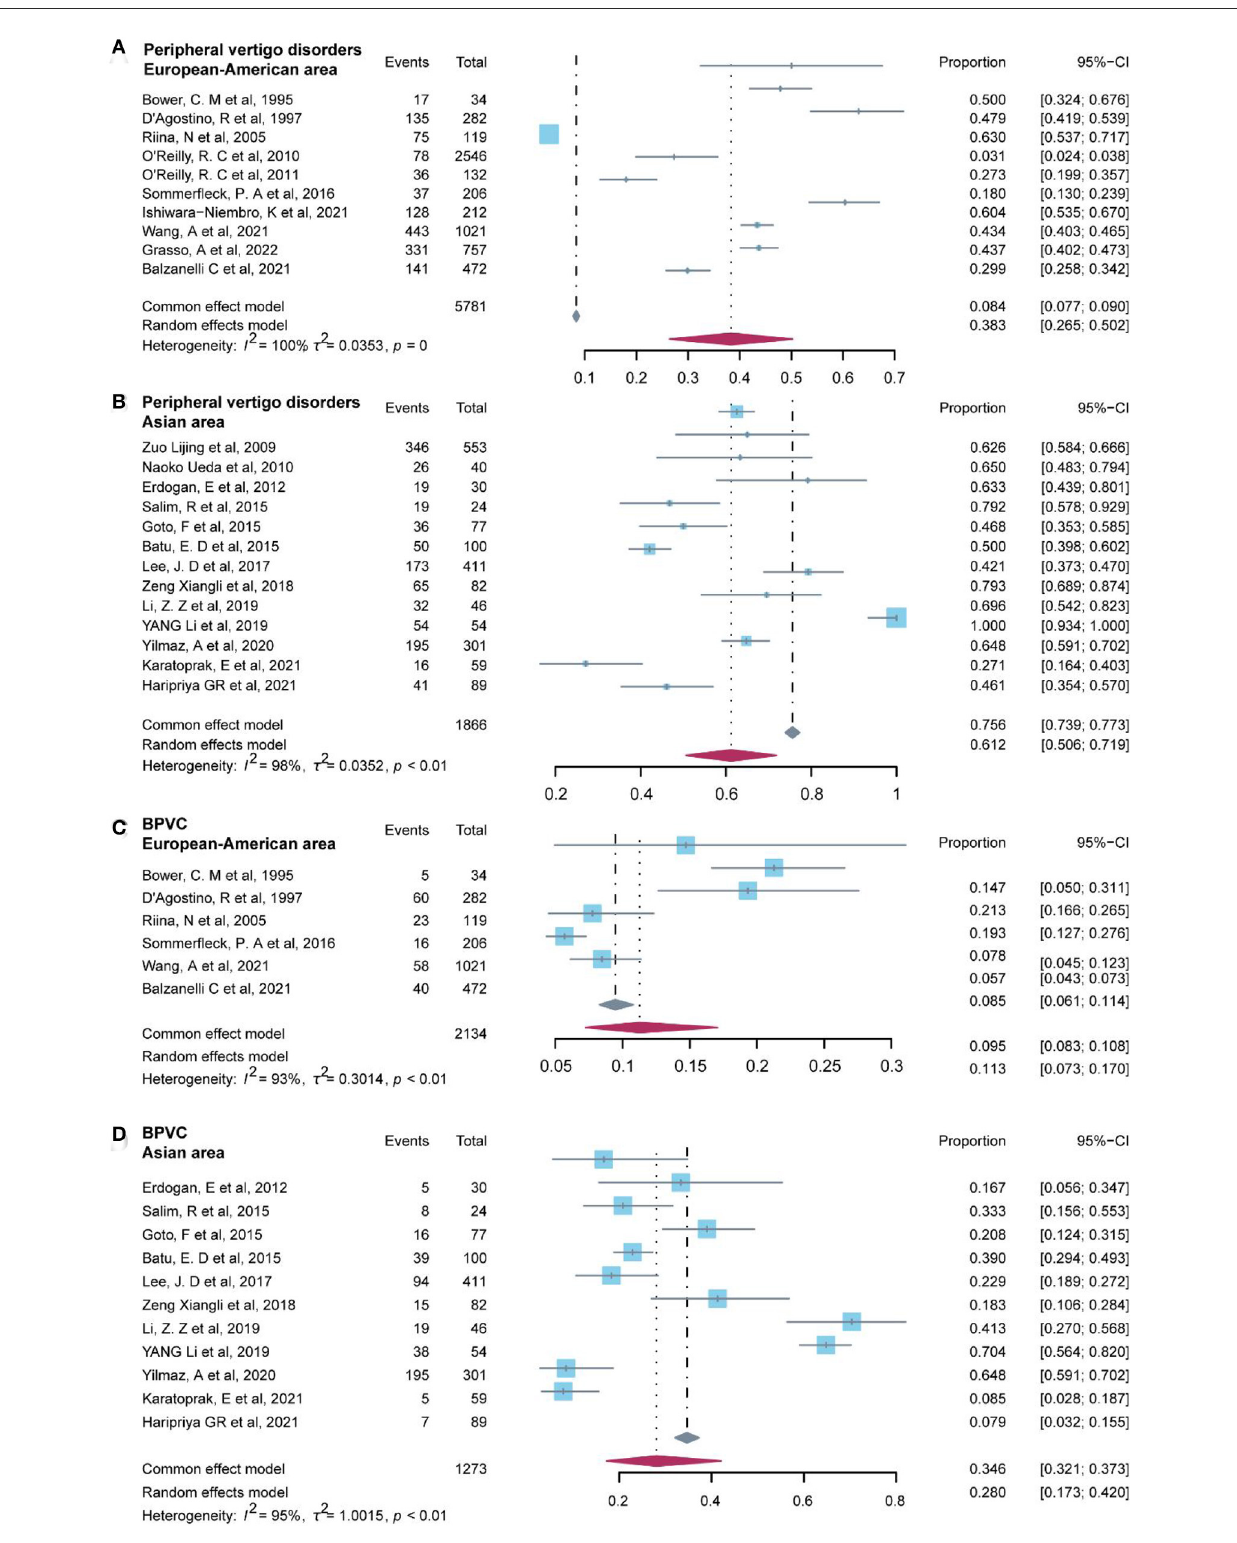
FIGURE6 Forest plot of peripheral vertigo disorders and BPVC in different areas.